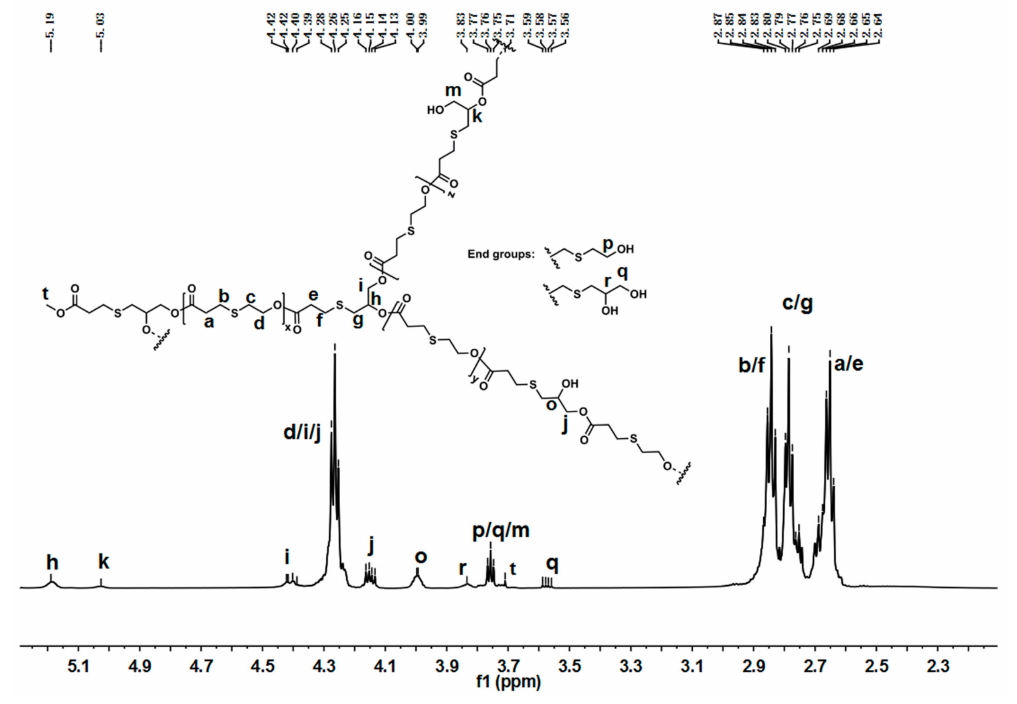
Figure 3. 1 H-NMR of lPTE-1 in CDCl 3